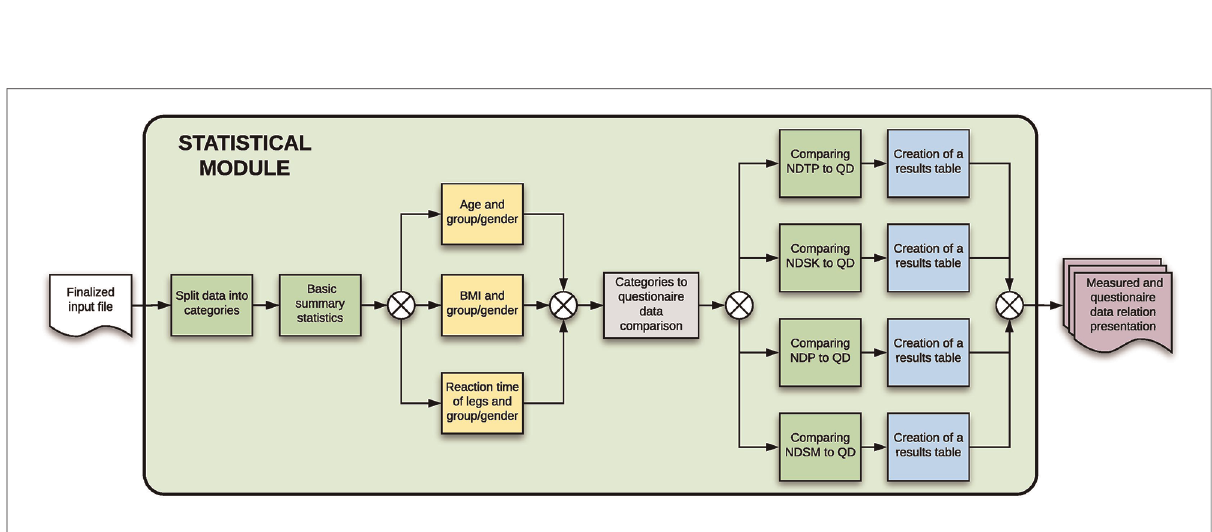
FIGURE 12 Statistical module — the fi gure describes each of the steps that will be done automatically by the module, showing also the process inputs and outputs.